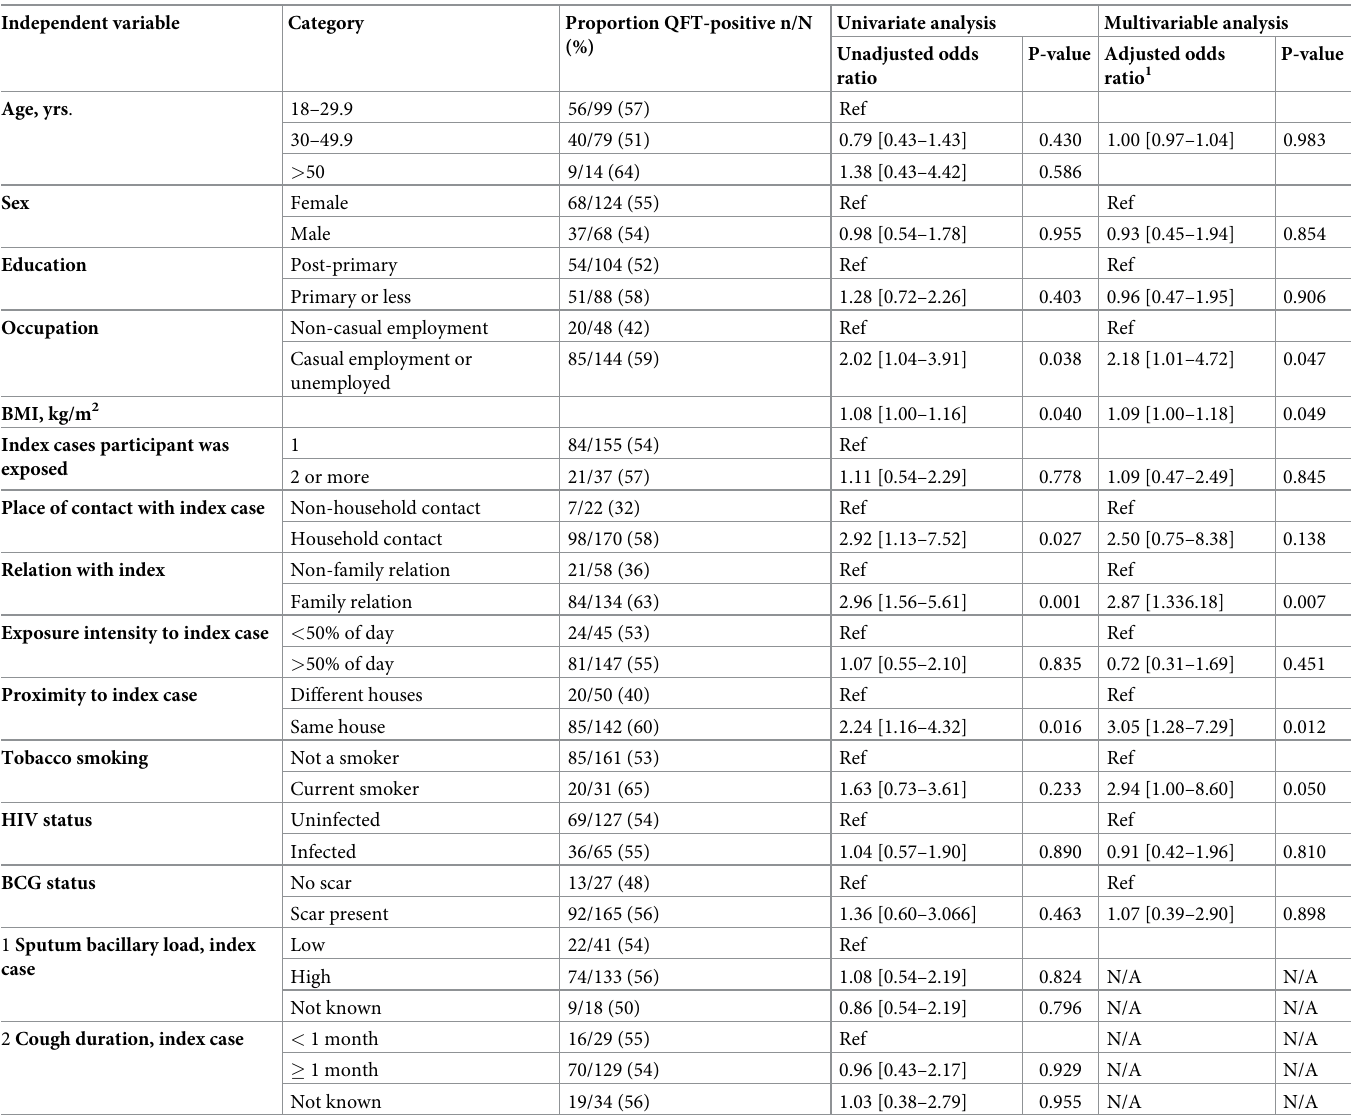
Table 2. Factors associated with IGRA